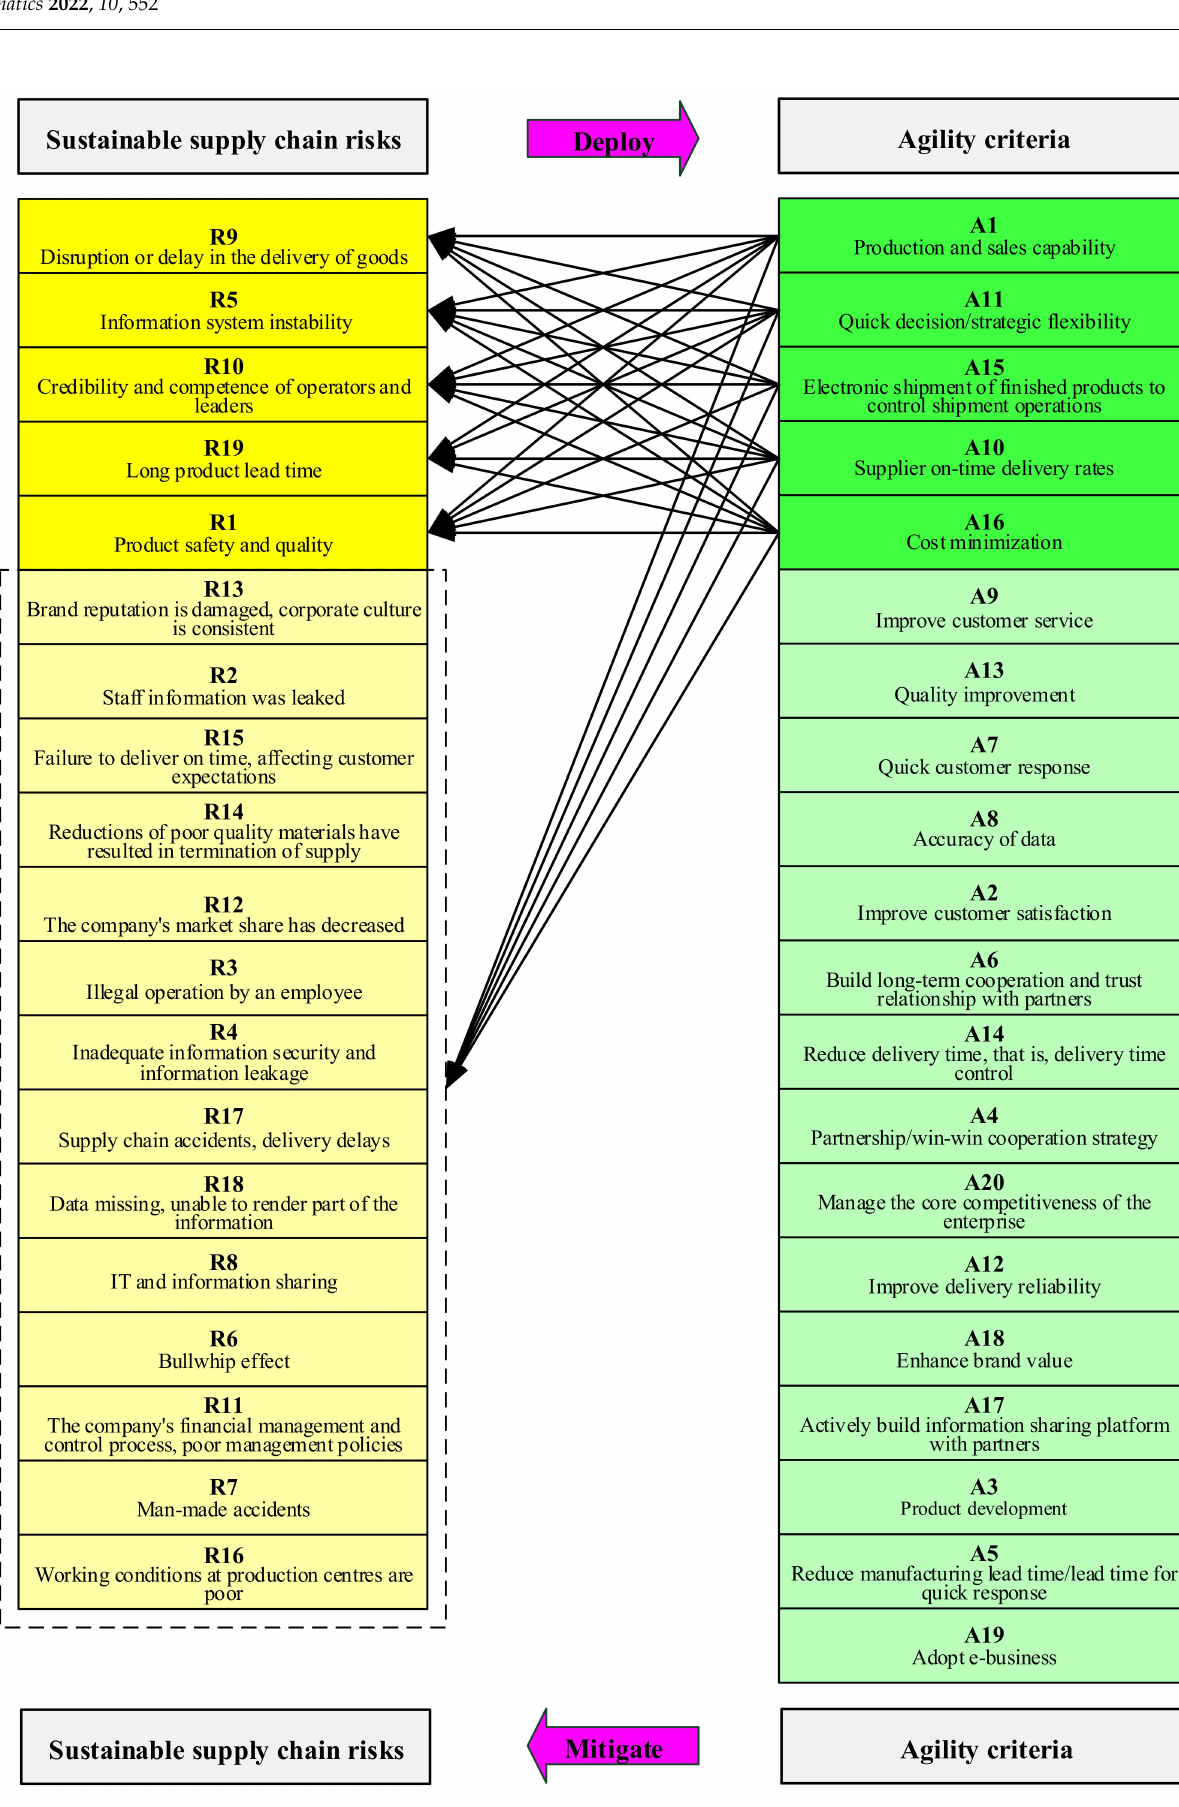
Figure 5. Agility-enhancing solutions to mitigate SSCRs in the